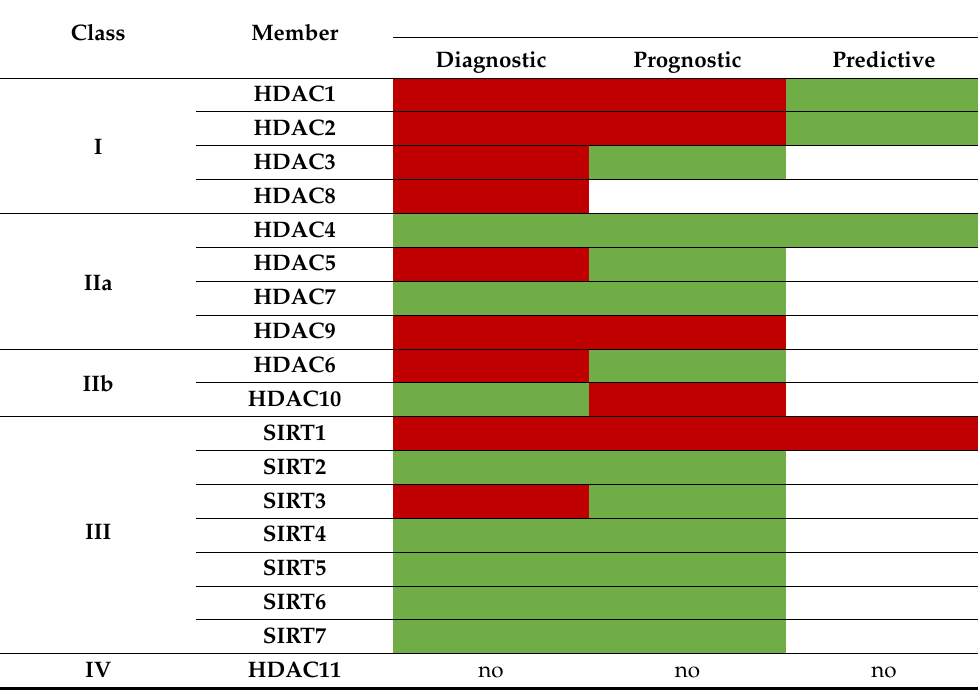
Table 3. Characterization of HDACs as potential diagnostic, prognostic, or predictive biomarkers. Green: potential biomarker; red: controversial biomarker; white: no